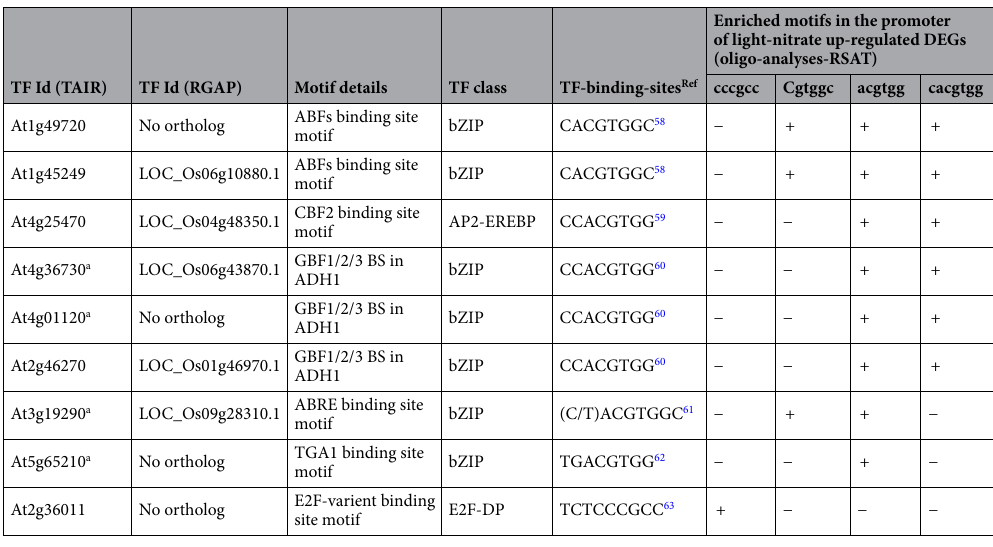
Table 1. Nitrate-responsive transcription factors and their experimentally validated DNA binding sites. Ref reference. a Nitrate regulated transcription factors in Arabidopsis 57 .